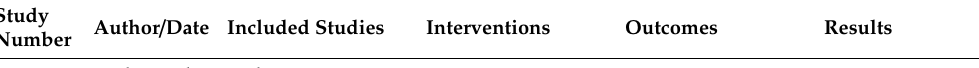
Table 4. Interventions directed smoking cessation and reducing other tobacco products or secondhand smoke exposure during